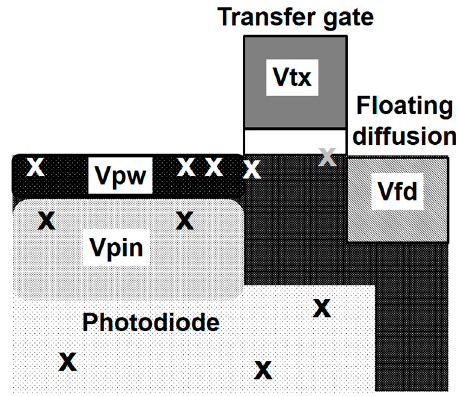
Figure 7. Dark current sources marked by “X” and pixel biases.